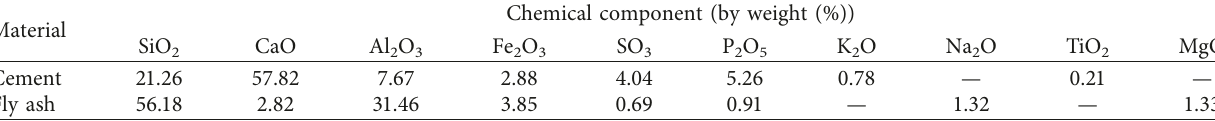
Table 1: Chemical composition of Portland cement and fly ash.